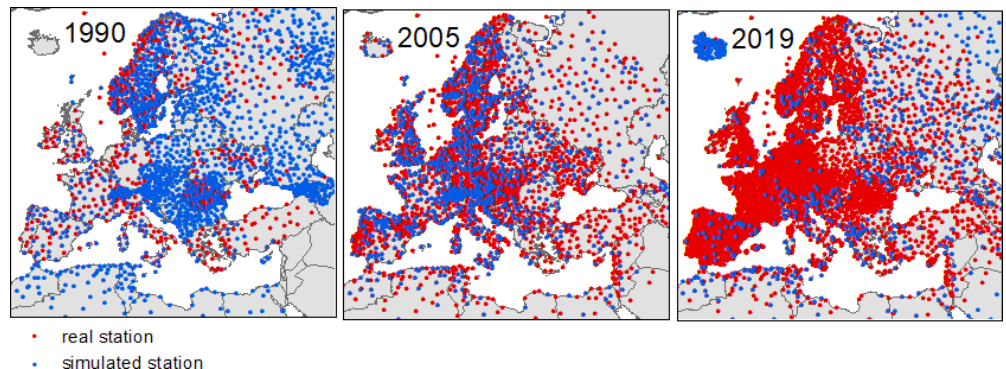
Figure 6. Coverage of existing and simulated stations used for the 6-hourly temperature fields for 1990, 2005, and 2019.